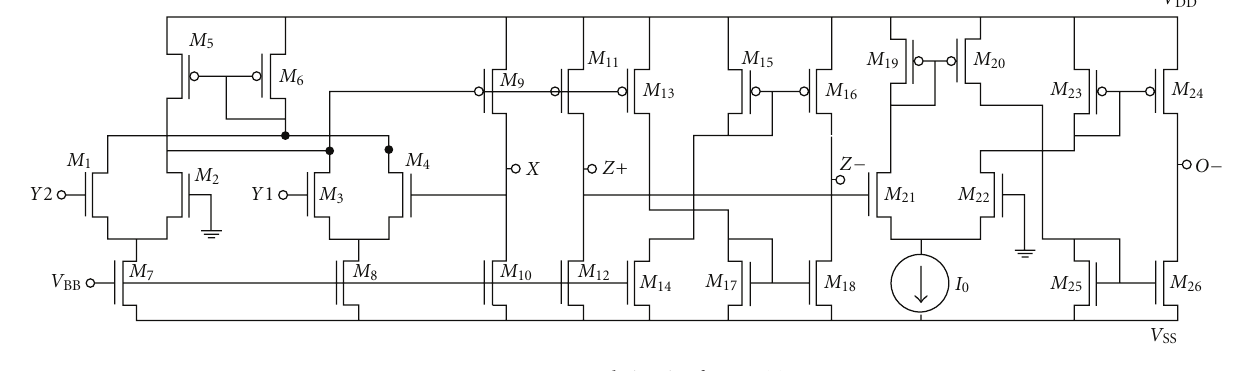
Figure 2: Internal circuit of DVCCTA. Table 3: Comparative study of the available similar type of single active element-based VM filters.